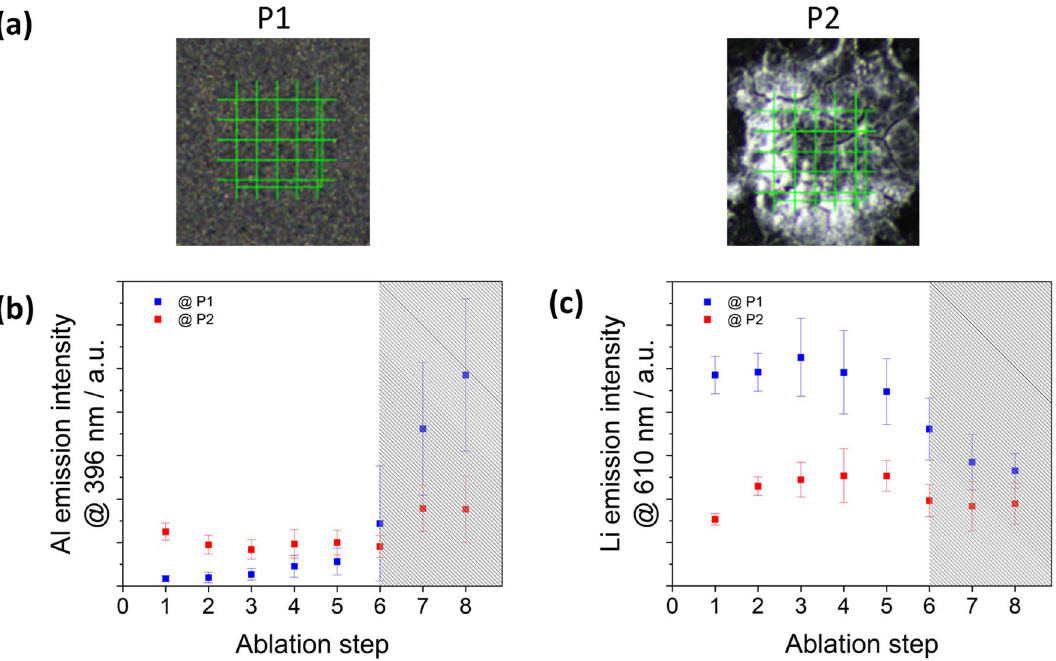
Figure 7. ( a ) P1 non-degraded NMC surface; P2 bloom due to degradation by air humidity of φ = 97% for t = 18 h; ( b ) emission intensity of the aluminum line at 396.15 nm (hatched: carrier foil); ( c ) background- corrected emission intensity of the lithium line at 610.36 nm (hatched: carrier foil); points represent the mean values and the error bars the standard